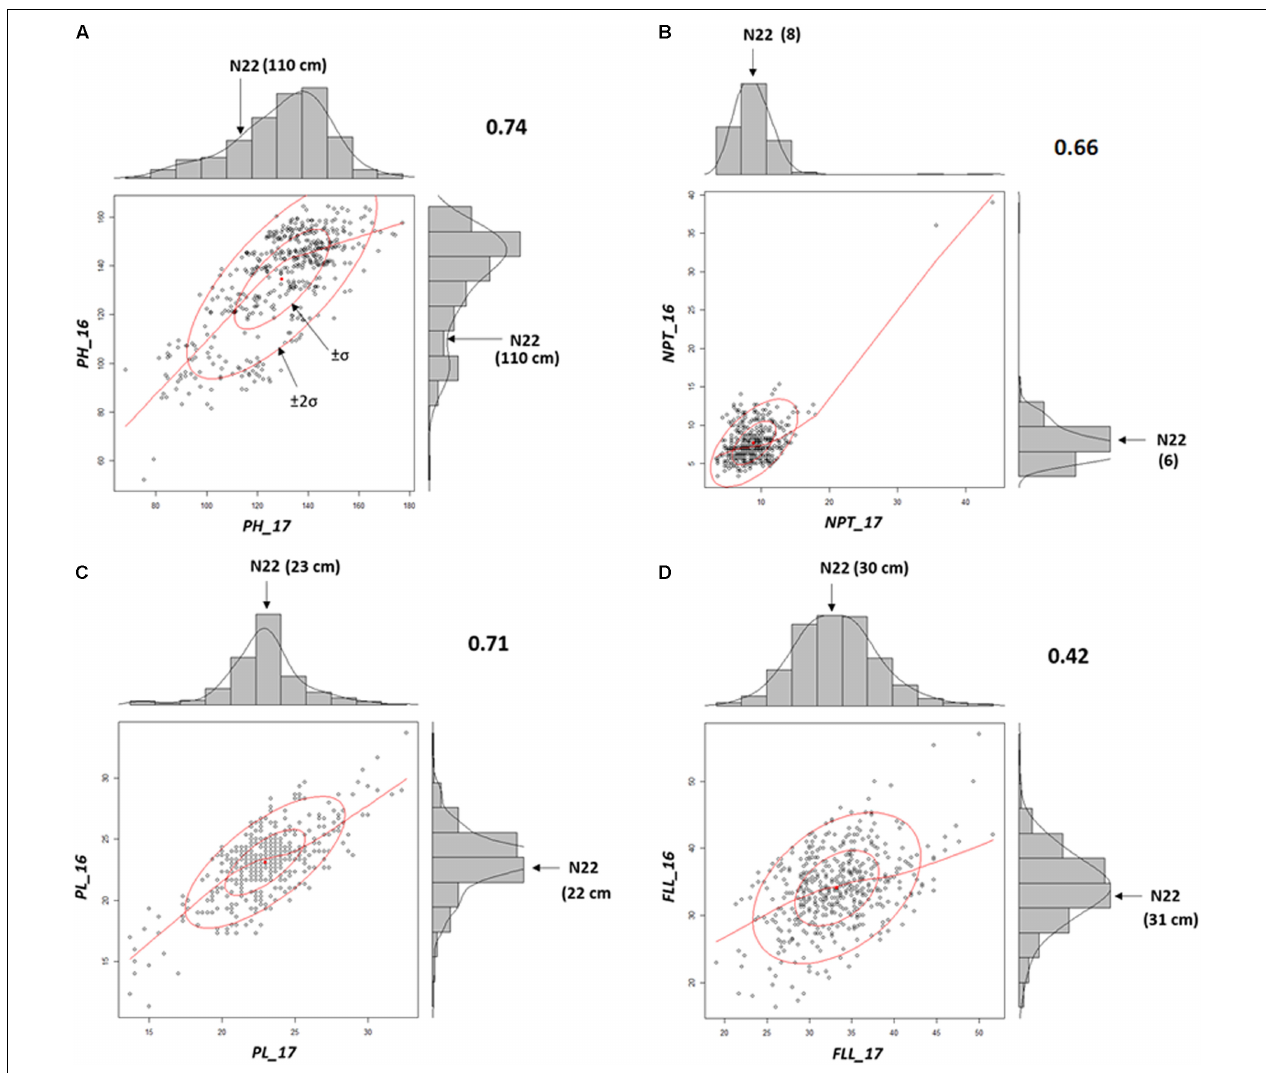
FIGURE 3 | Morphological trait correlations across two years indicating the stability of the mutants (A) Plant Height (PH); (B) Panicle length (PL); (C) Number of productive tillers (NPT); and (D) FLL. All correlations were according to Pearson’s linear correlations and were found to be positive and significant at P <